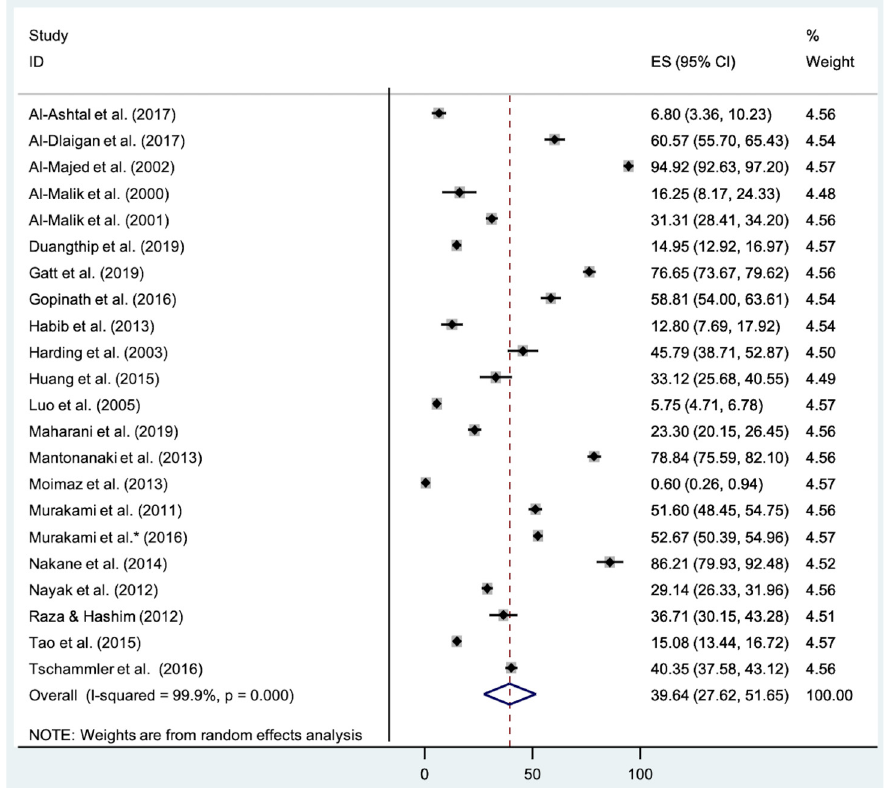
Figure 2. Meta-analysis and forest plot showing combined prevalence rates of all included